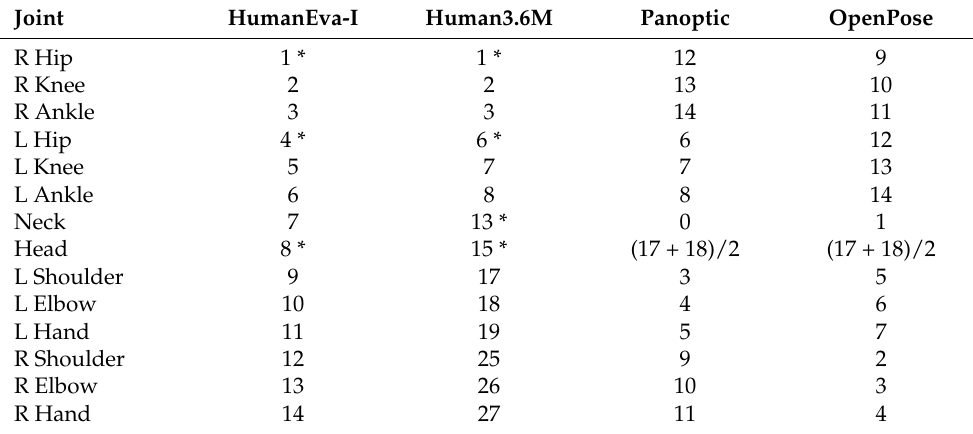
Table 5. Our joint definitions for the different datasets and OpenPose. The numbers in the table correspond to the joint number in the datasets’ original joint definition. The joints marked with * were repositioned in the harmonization process. Joint HumanEva-I Human3.6M